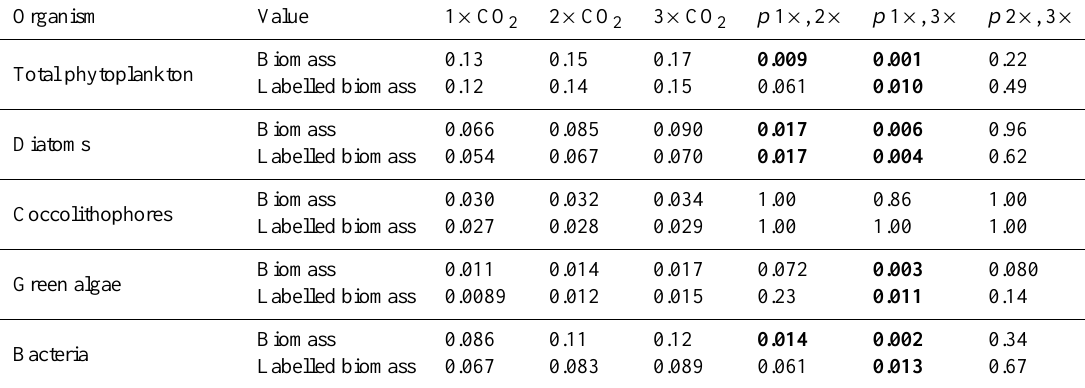
Table 1. Average non-labelled biomass (mgCl − 1 ) and labelled biomass (µgCl − 1 ) of major phytoplankton groups and bacteria in the post-bloom phase (day 10–day 24) with p -values from post-hoc Bonferroni analyses after repeated measures ANOVA.